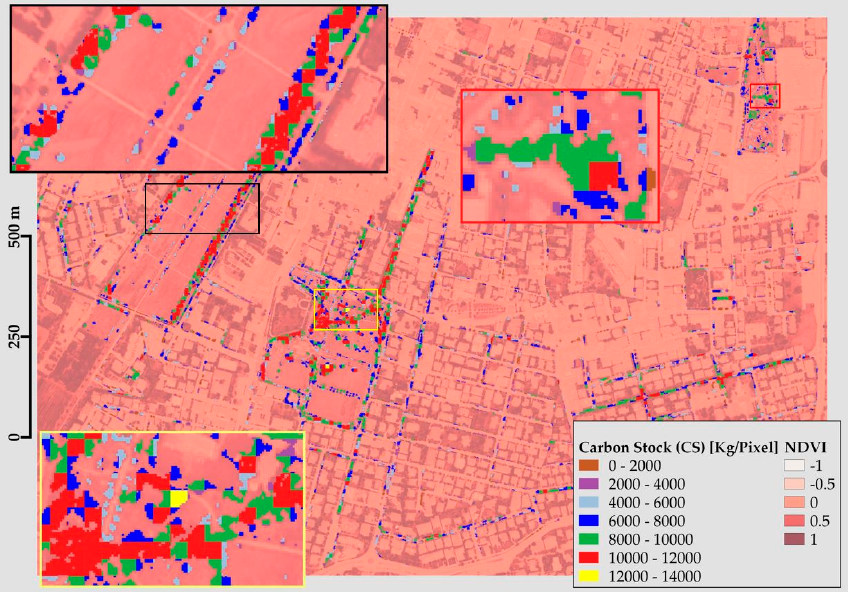
Figure 9. The estimated (QGIS) CS based on di ff erent dominant species and their distributions.